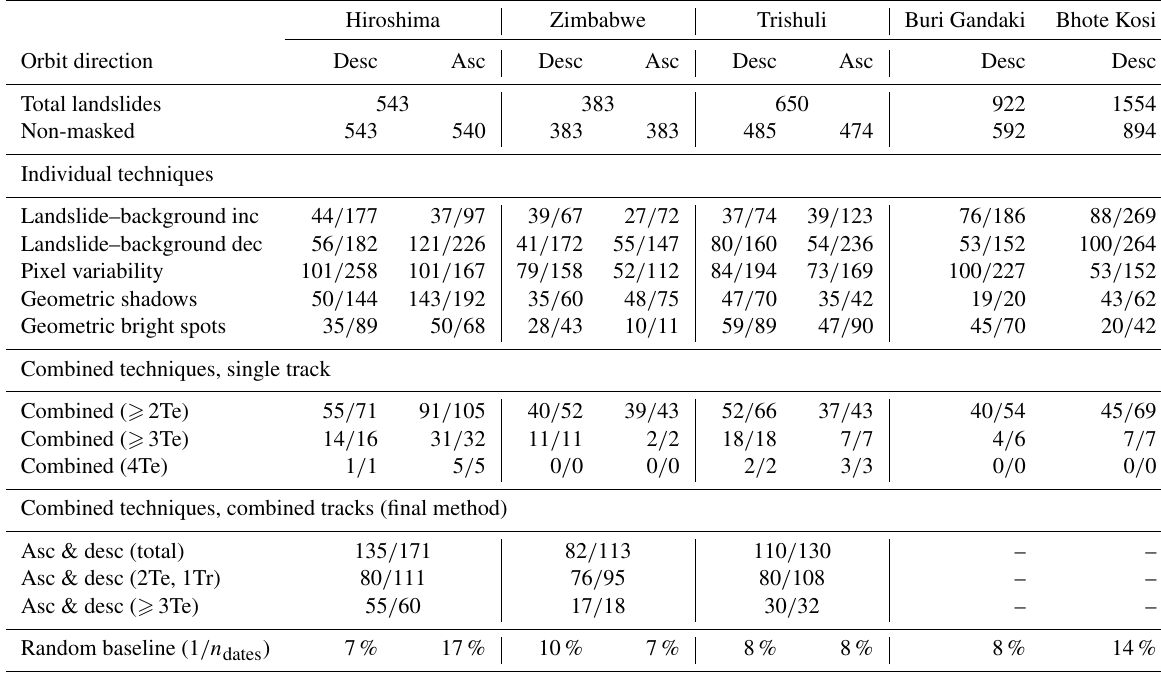
Table 2. For each case study, the total number of landslides, the number that are masked due to foreshortening or layover in the SAR images, and amplitude timing results for the four techniques described in Sect. 2. For each technique and combination of techniques, we give the number of correctly assigned date pairs against the total number of assigned date pairs. Where timings were obtained from combinations of techniques (Te) or tracks (Tr), the number of these is specified in